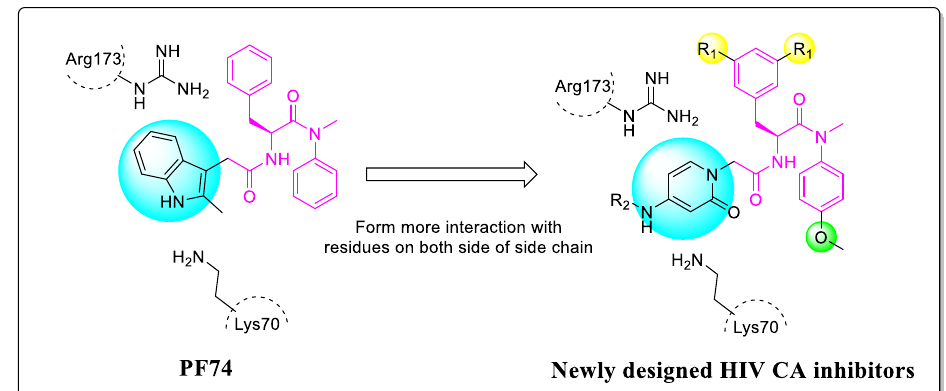
Figure 3. The design rationale of the 2-pyridone-containing compounds.